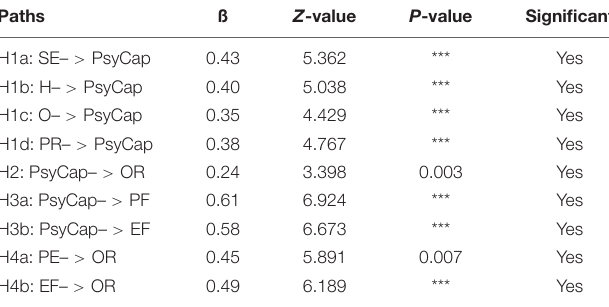
TABLE 6 | Testing direct relationship.